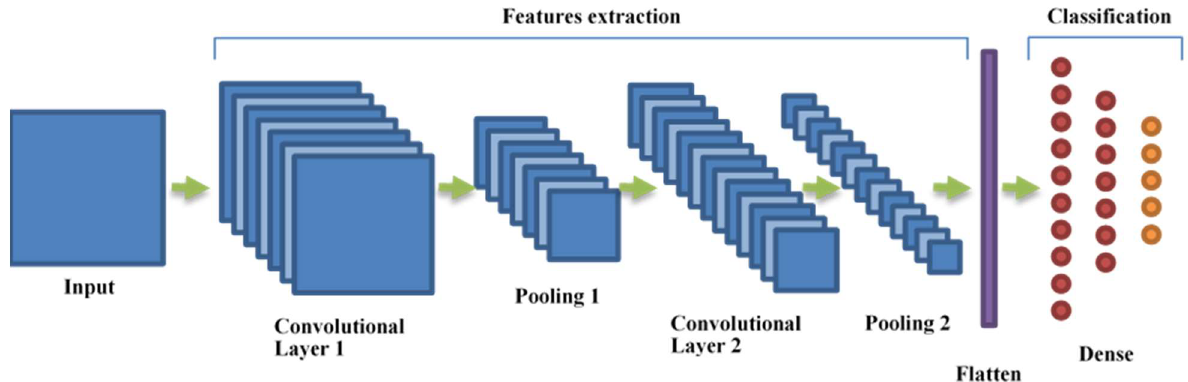
Figure 2. The typical architecture of a convolutional neural network.